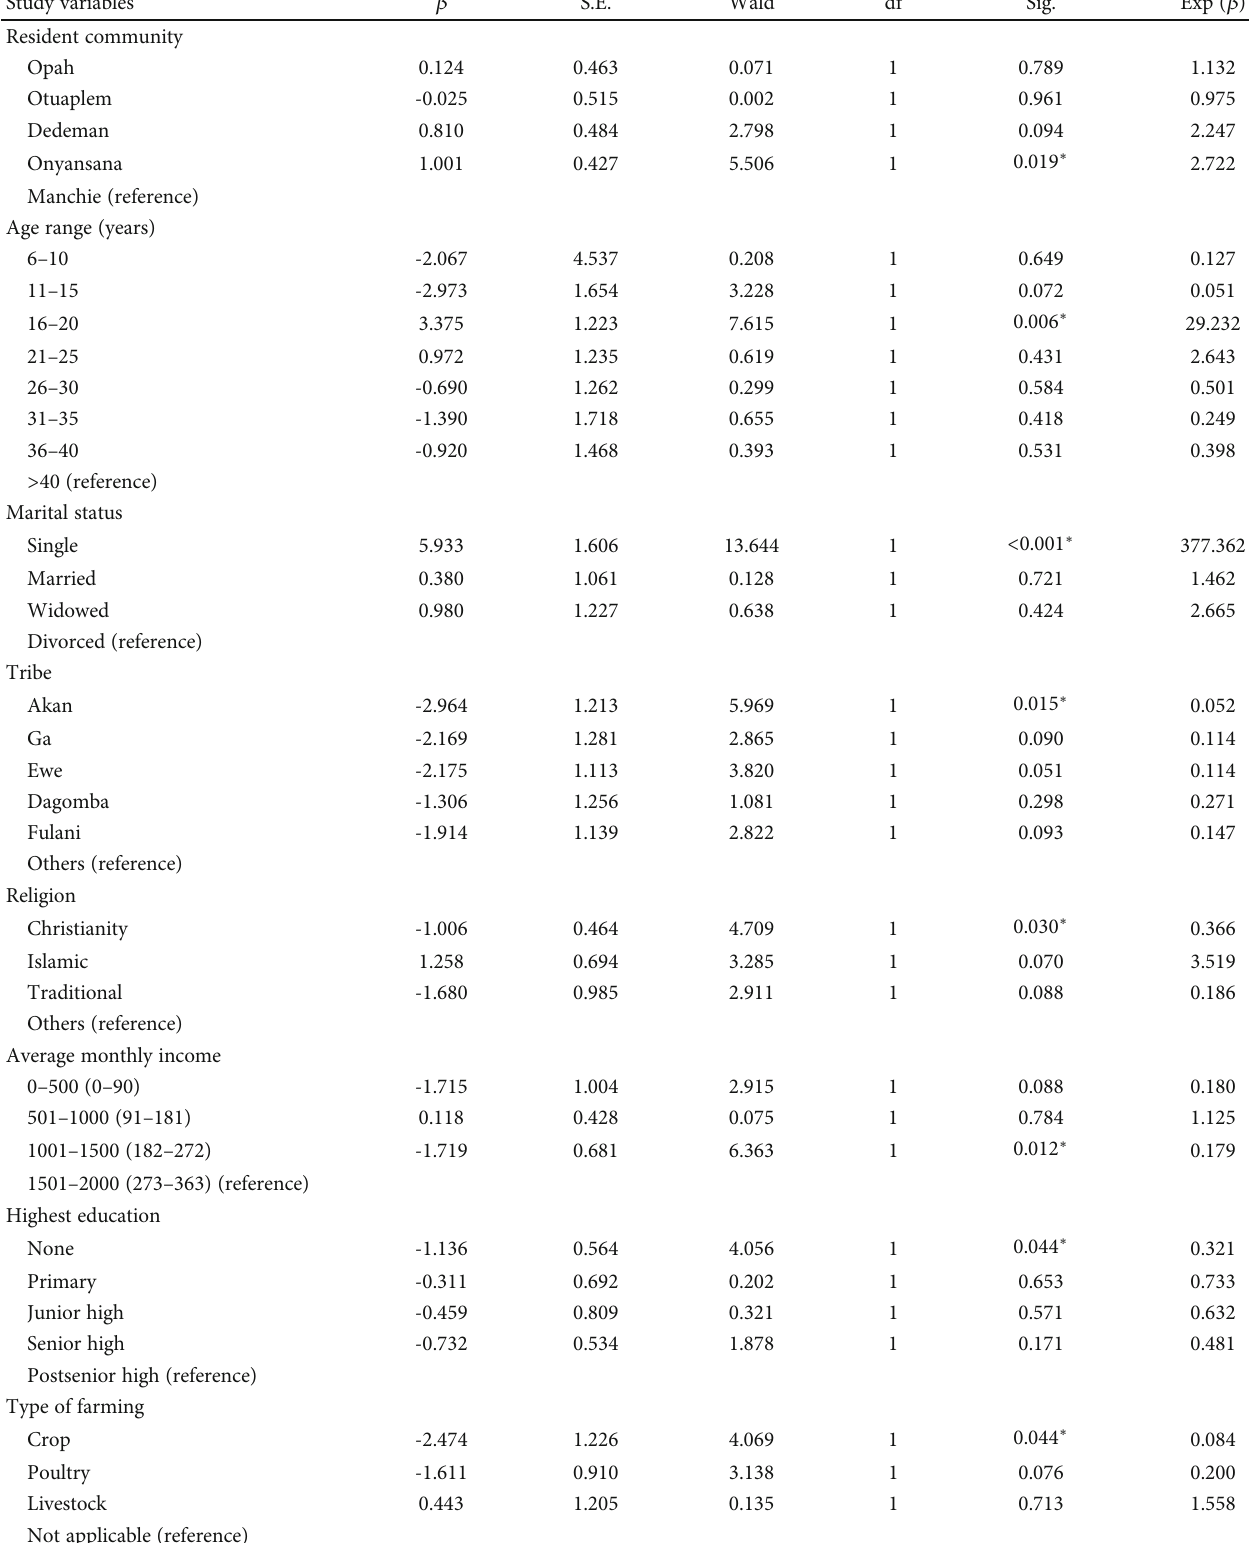
Table 2: Logistic regression analysis of signi fi cant associations of enteroparasitism with study